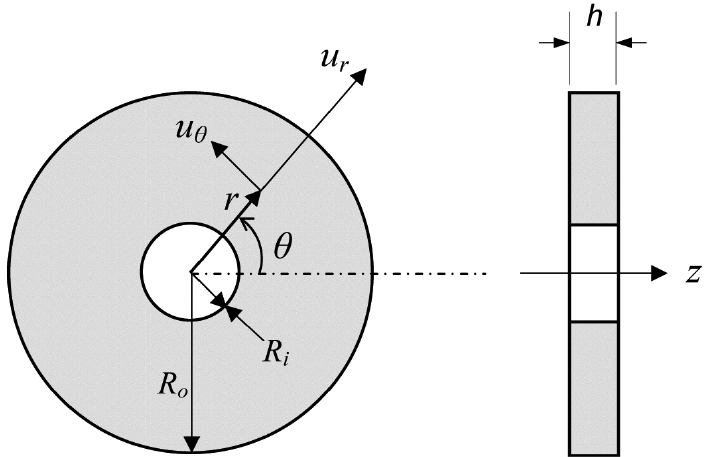
Fig. 1. Geometry and coordinate system used for in-plane vibration analysis of an annular